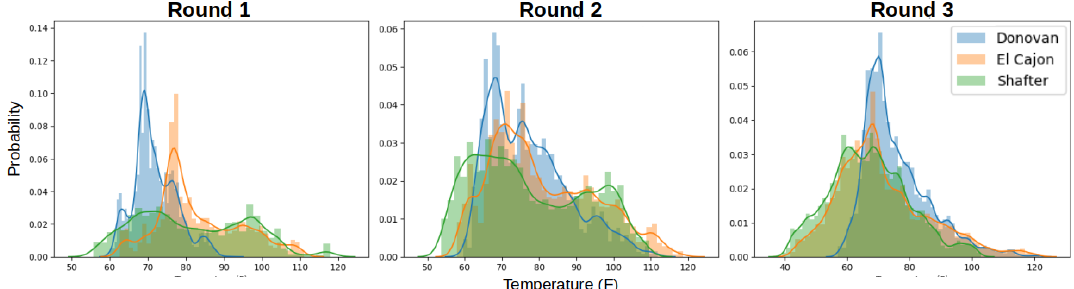
Figure A1. Temperature distributions for each location, by round.